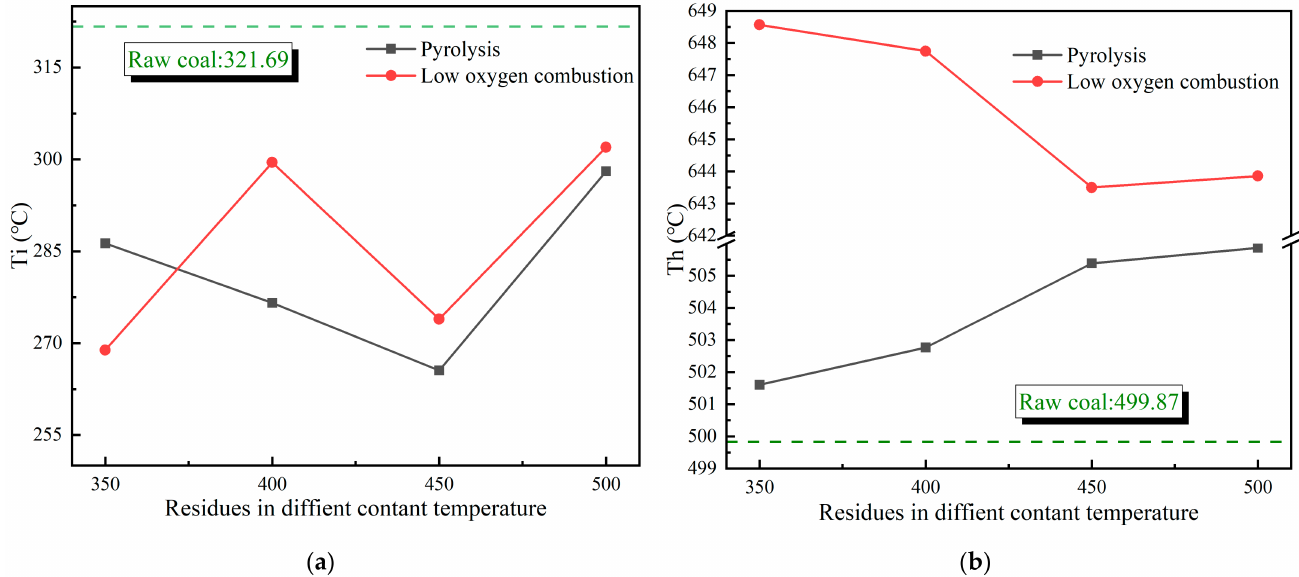
Figure 7. Variation curve of oxidation characteristic parameters of pyrolysis and low oxygen combustion residues. ( a ) The oxidation characteristic parameter is ignition temperature, T i . ( b ) The oxidation characteristic parameter is burnout temperature, T h